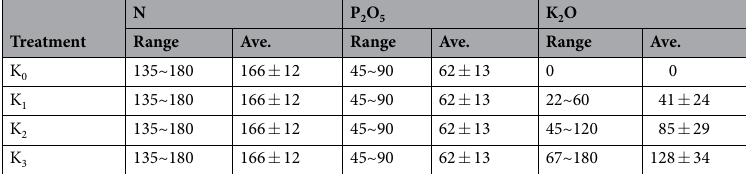
Table 4. Range and average of fertilizer application rate of the 54